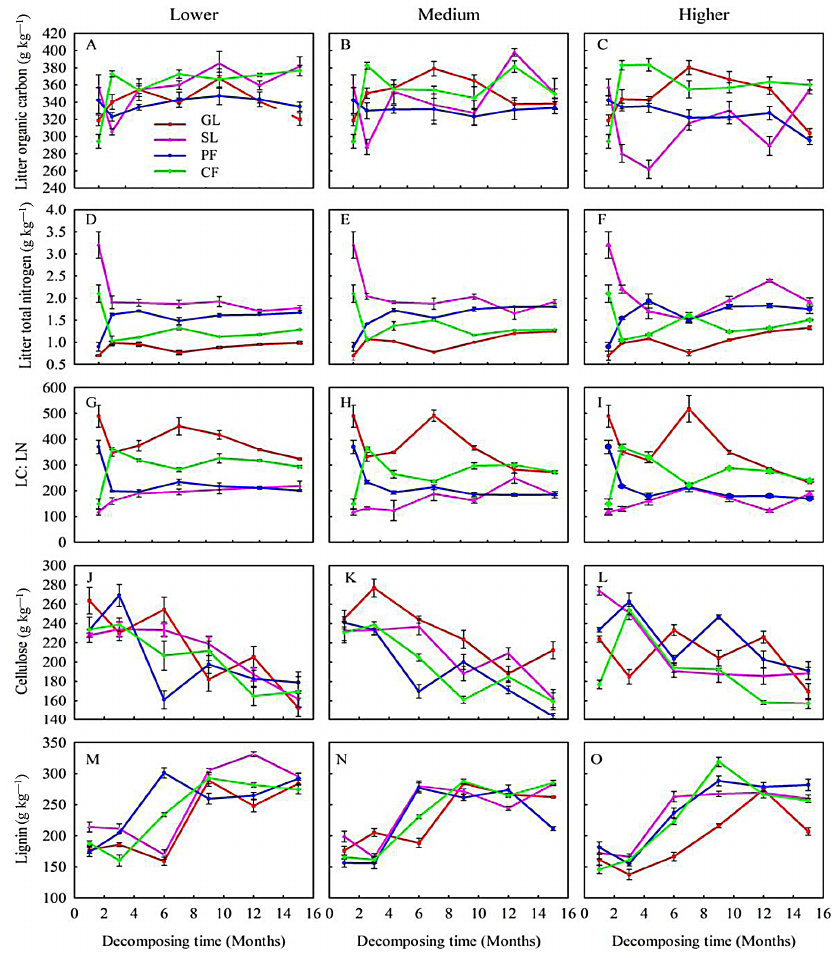
Figure 2. Chemical properties of litter changed with decomposing time (months) in different restoration stages. Lower, medium, higher represent three different water gradients, respectively. LC: LN indicates the ratio of litter organic carbon to total nitrogen. GL, grassland; SL, shrubland; PF, pioneer forests; CF, climax forests. ( A – C ) represent the dynamics of litter organic carbon under lower water, medium water and higher water treatment, respectively; ( D – F ) represent the dynamics of litter total nitrogen under lower water, medium water and higher water treatment, respectively. ( G – I ) represent the dynamics of the ratio of litter organic carbon (LC) to litter total nitrogen (LN) under lower water, medium water and higher water treatment, respectively; ( J – L) represent the dynamics of cellulose content under lower water, medium water and higher water treatment, respectively. ( M – O ) represent the dynamics of lignin content under lower water, medium water and higher water treatment, respectively. All bars represent the mean ± standard error.